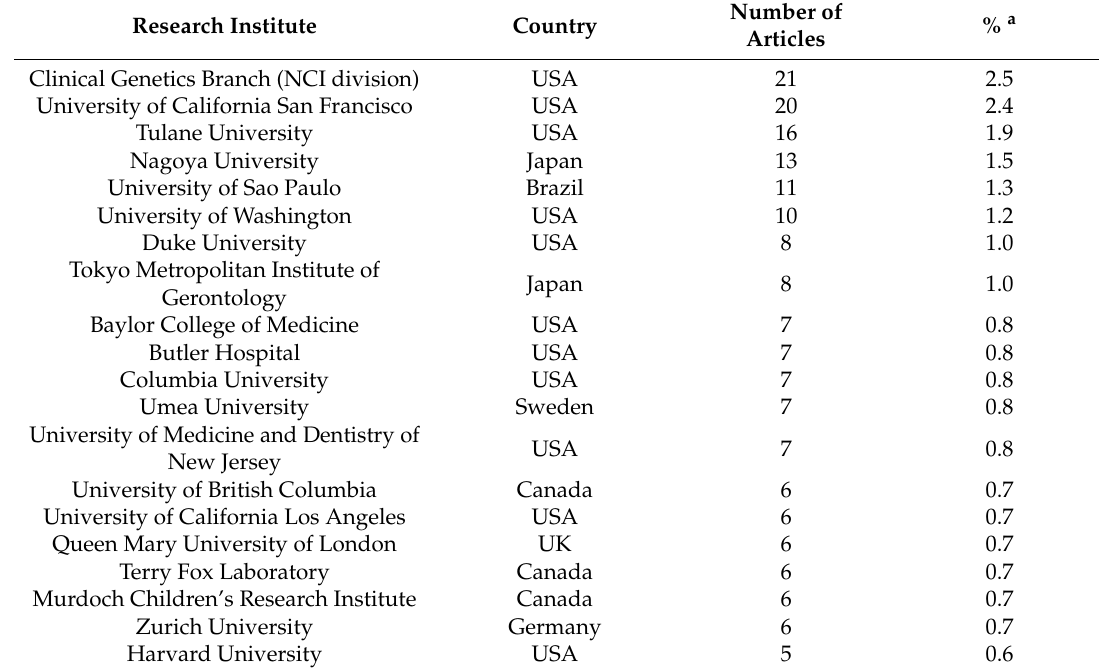
Abbreviations: NCI, National Cancer Institute. a Percentage calculated out of the retrieved 840